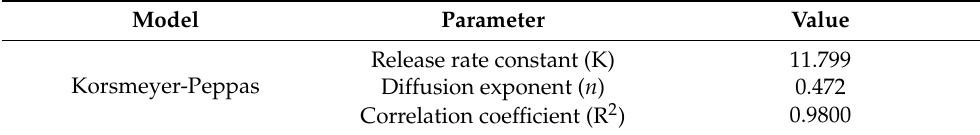
Table 3. DSP dissolution kinetics from AP-8 using the Korsmeyer-Peppas model.